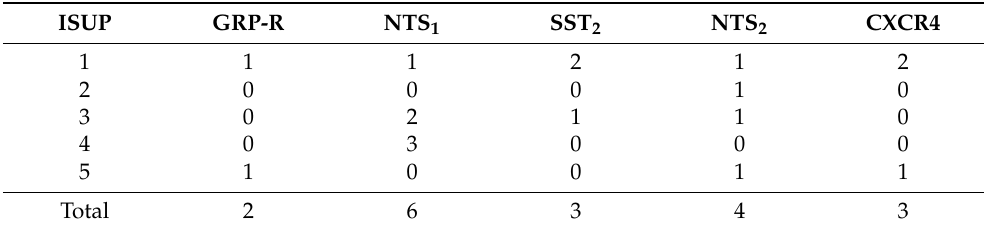
Table 4. Number of Delta ≥ PSMA for GRP-R, NTS 1 , SST 2 , NTS 2 and CXCR 4 . Note: ISUP5 NTS 2 >> PSMA (95% vs. 44%). ISUP GRP-R NTS 1 SST 2 NTS 2 CXCR4